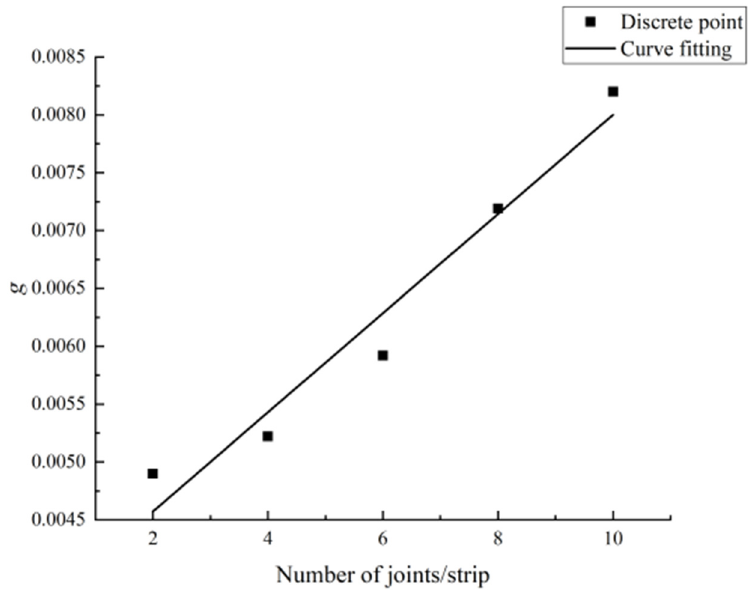
Figure 12. Fitting curve of parameter g .